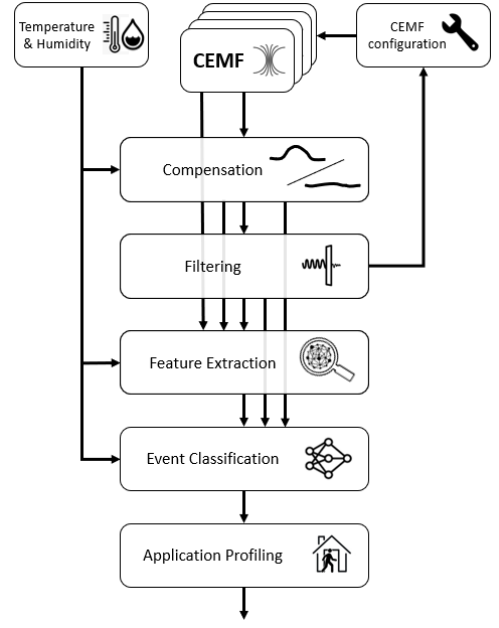
Figure 5. CEMF algorithm diagram.